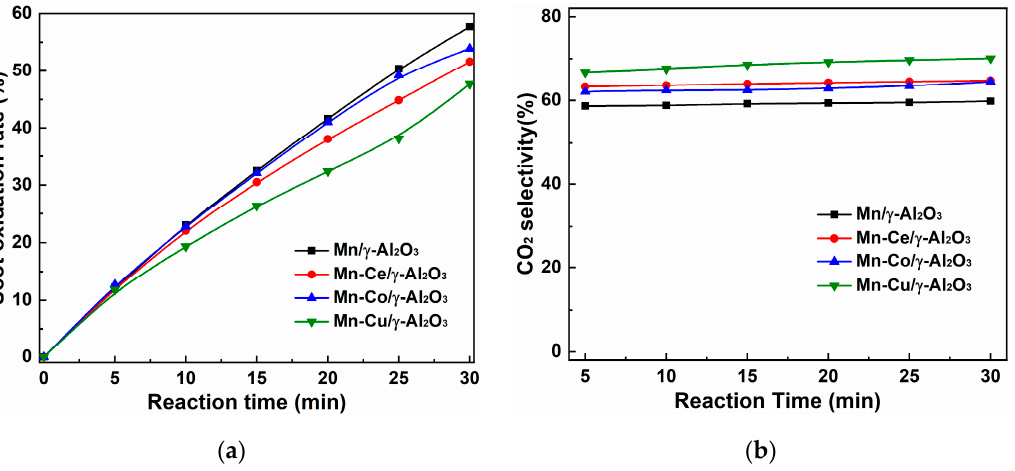
Figure 5. Effect of Mn-X/ γ -Al 2 O 3 (X = Ce, Co and Cu) on plasma–catalytic soot oxidation: ( a ) oxida- tion rate and ( b ) CO 2 selectivity (discharge power: 14 W, reaction temperature: 150 °C, oxygen con- tent: 10 vol.% and gas flow rate: 500 mL·min − 1 ).